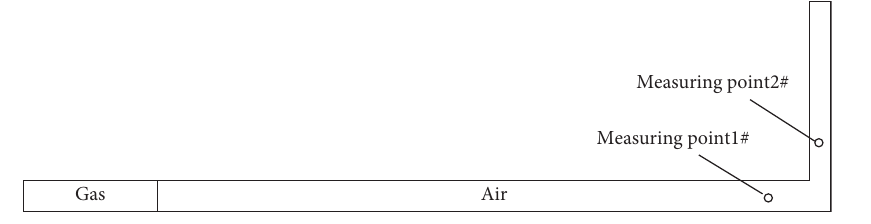
Figure 1: Section diagram of physical model.